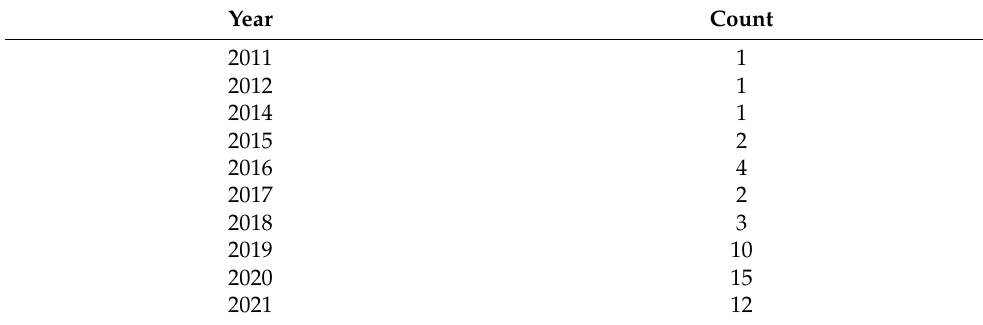
Table 4. Publication year vs. count.